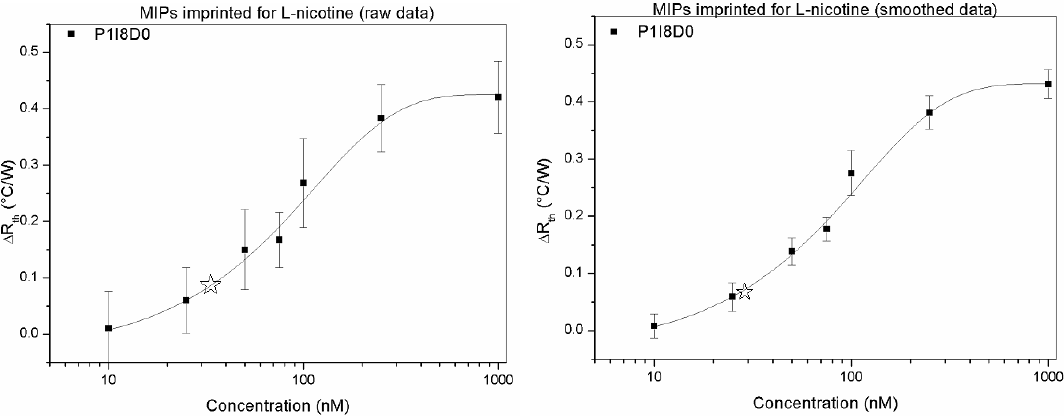
Figure 7. Dose-response curve of the MIP imprinted for L-nicotine for the raw and smoothed data. The difference in R is plotted against logarithmic presented concentration. th The concentration of L-nicotine varies in a range from 10 nM to 1 µM. The mathematical detection limit is illustrated by the asterisk, which is 35 nM for the raw data en 29 nM for the smoothed